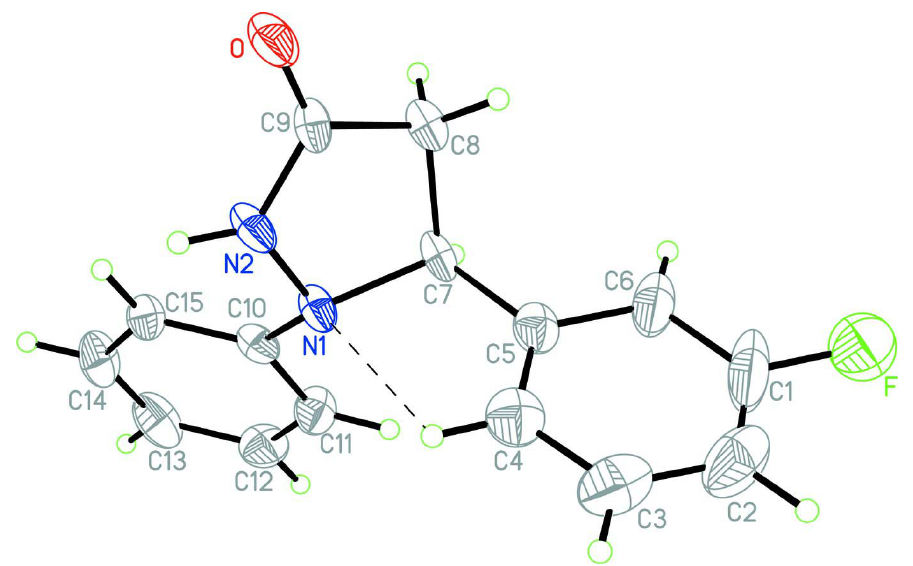
Figure 1 The molecular structure of the title molecule, with the atom-numbering scheme. Displacement ellipsoids are drawn at the 50% probability level. Hydrogen bond is shown as dashed line.